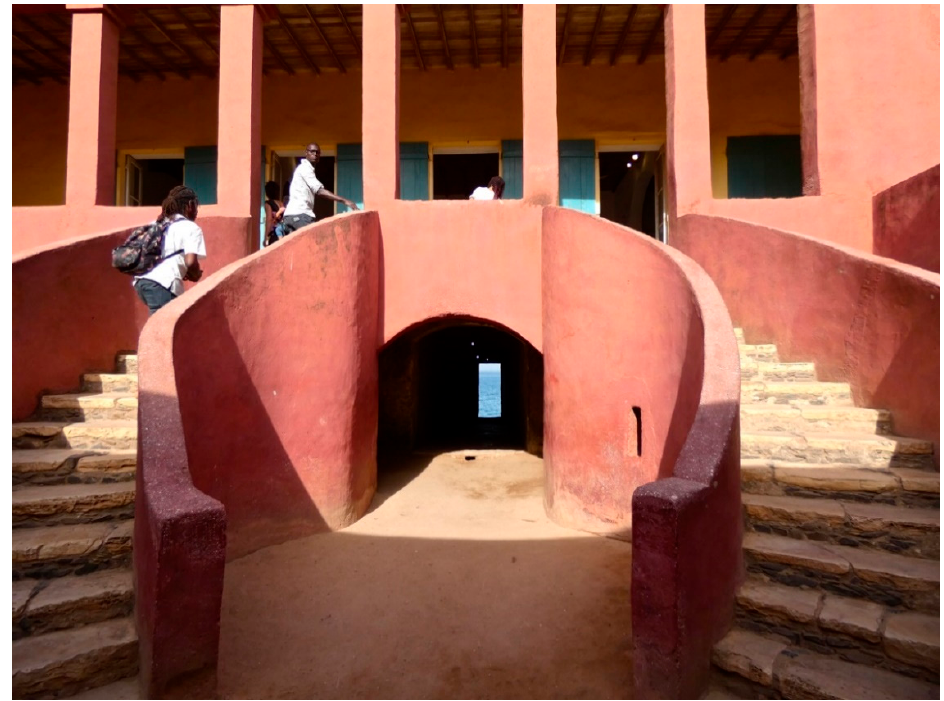
Figure 2. The House of Slaves ( la Maison des Esclaves ), Gorée Island. Wikimedia Commons (photo by John Crane). Note the “Door of No Return” in the lower level.